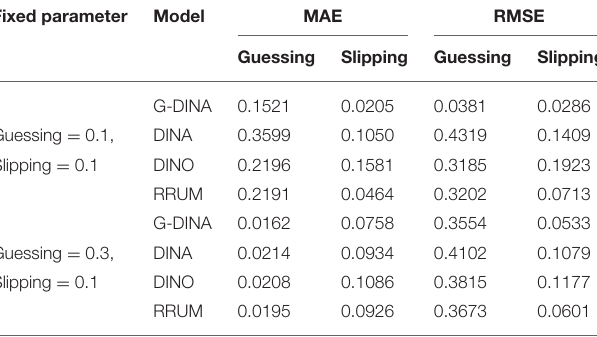
TABLE 6 | Parameters returned by different cognitive diagnosis models. Fixed parameter Model MAE RMSE Guessing Slipping Guessing